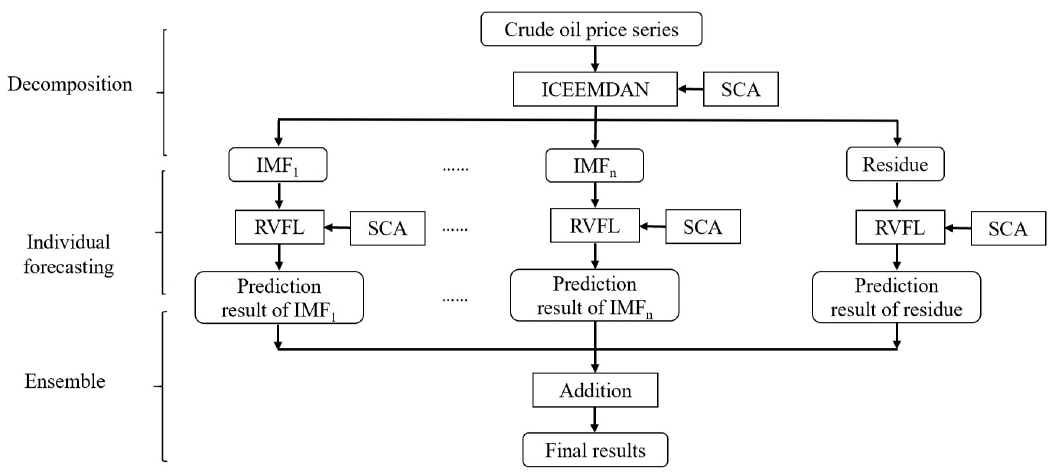
Figure 2. The flowchart of the proposed ICEEMDAN-SCA-RVFL. ICEEMDAN: Improved complete ensemble empirical mode decomposition with adaptive noise; SCA: Sine cosine algorithm; RVFL: Random vector functional link neural